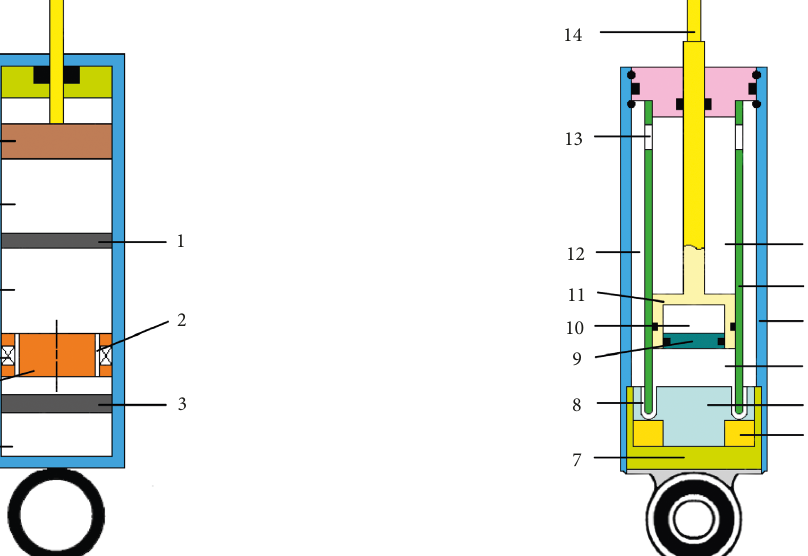
Figure 10: A longitudinal cross-sectional view of MR damper: 1, first floating piston; 2, passageway; 3, second floating piston; 4, third chamber; 5, second piston; 6, electric coil; 7, second chamber; 8, first chamber; 9, first piston [53].